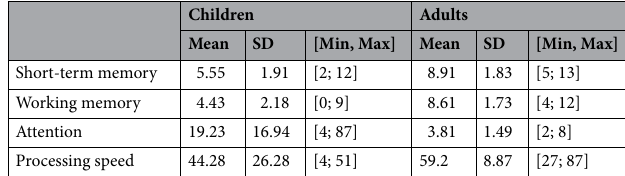
Table 5. Mean, Standard Deviation, minimum and maximum of raw scores of different neuropsychological